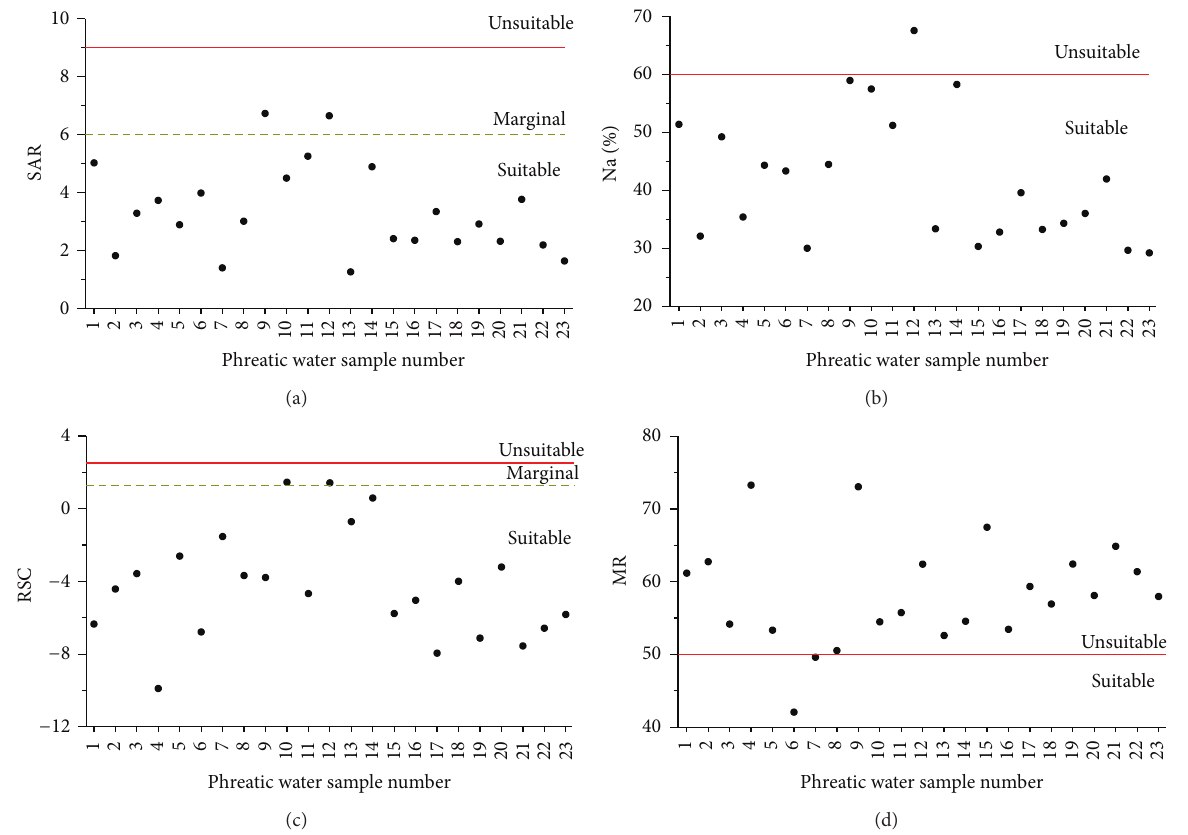
Figure 7: (a) SAR, (b) Na%, (c) RSC, and (d) MR for the phreatic water